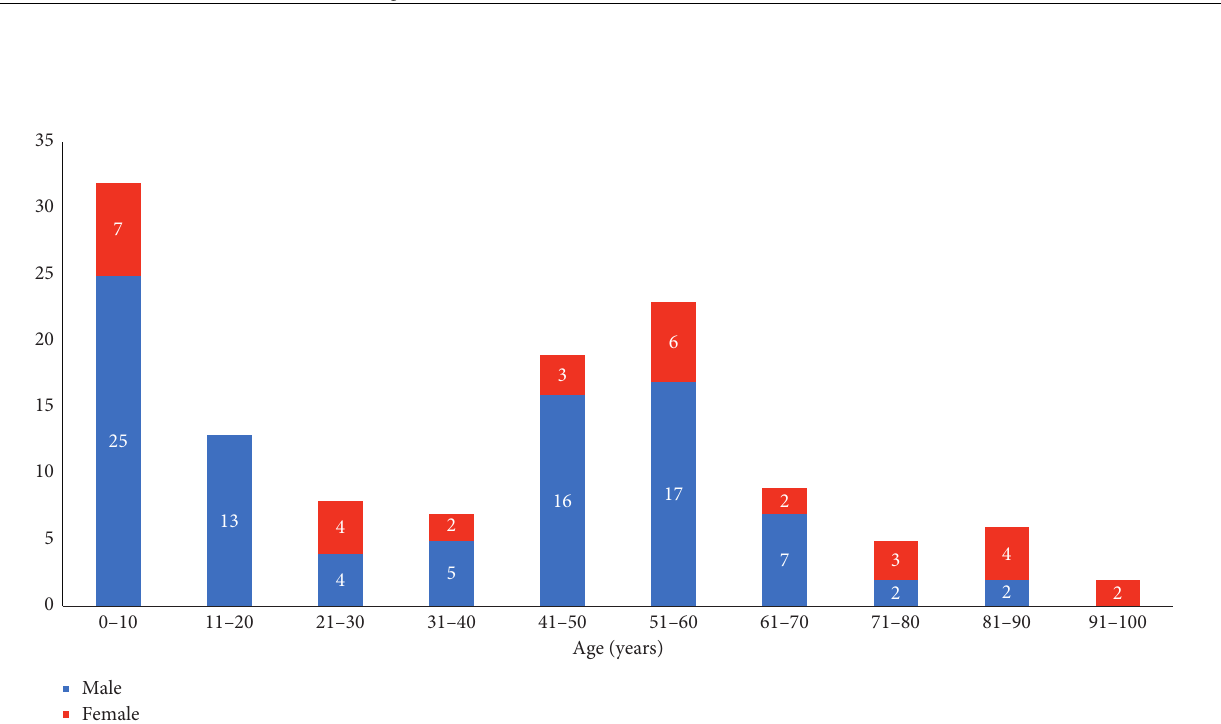
Figure 1: Age and sex distribution of patients at the time of the ocular